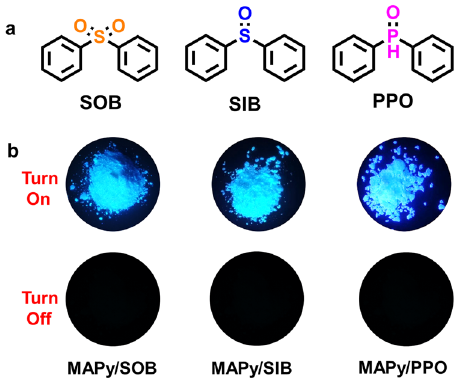
Fig. 4 Luminescence properties of guest molecules in other hosts. a Molecular structure of the reference hosts. b Luminescent images of the reference guest – host